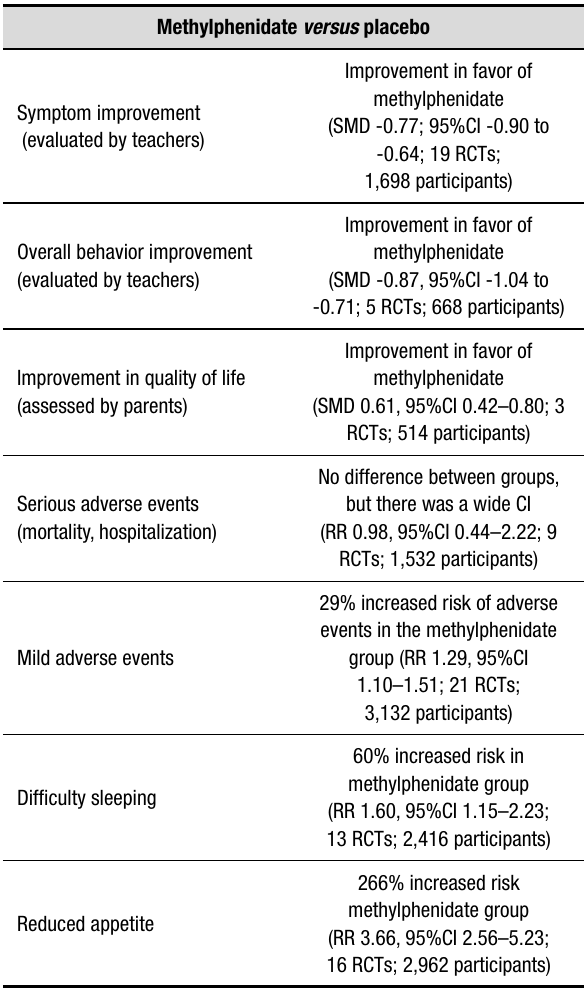
Table 1. Summary of the main outcomes: methylphenidate for attention deficit hyperactivity